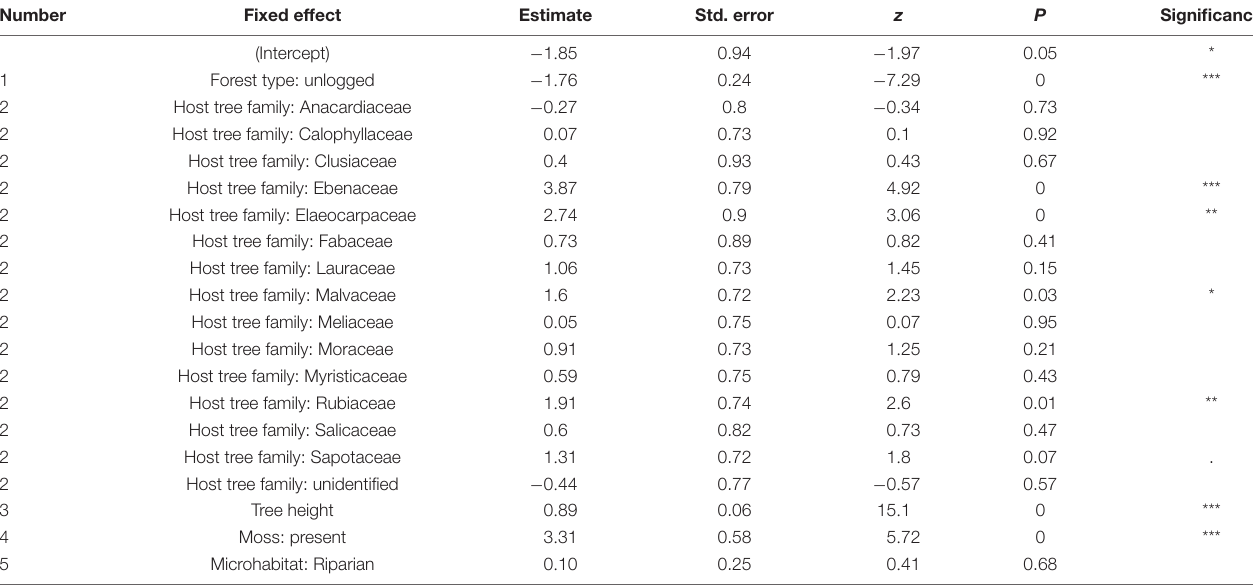
TABLE 4 | The output of a generalized linear mixed-effects model built using the abundance of epiphytes on the individual tree as a dependent variable. Number Fixed effect Estimate Std. error z P